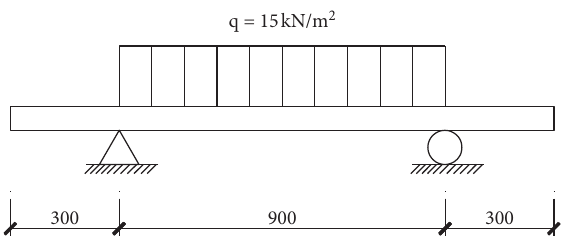
Figure 5: Loading diagram of the simply supported